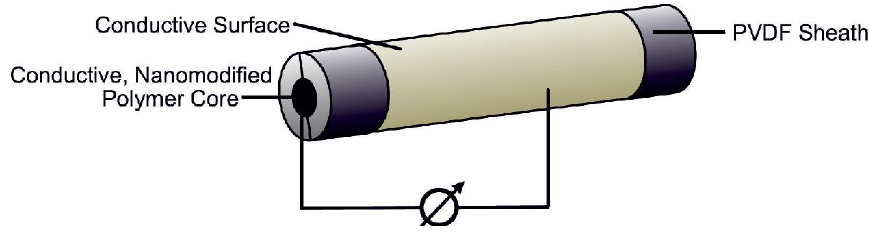
Figure 1. Schematic depiction of a melt spun bicomponent fiber with conductive poly(propylene) carbon nanotube (PP/CNT) core, poly(vinylidene fluoride) (PVDF) sheath and a conductive